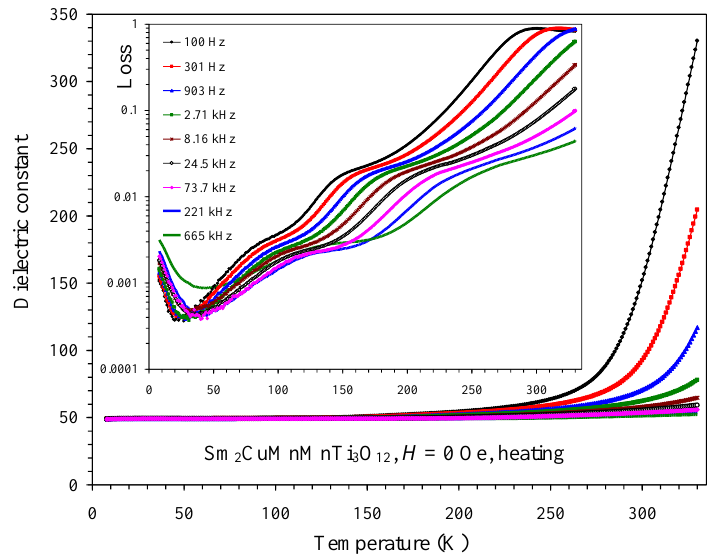
Figure 10. Temperature dependence of the dielectric constant at different frequencies in Sm 2 CuMn(MnTi 3 )O 12 . The inset shows temperature dependence of dielectric loss in the logarithmic scale.